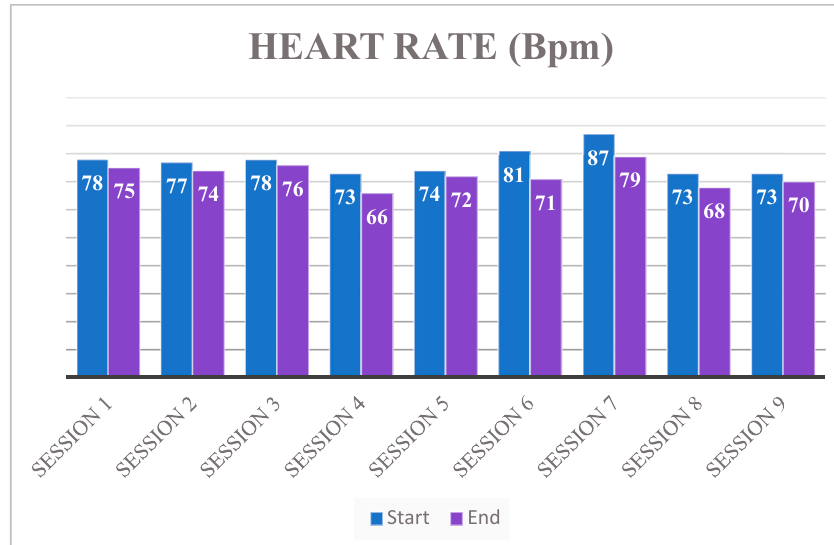
Figure 3. Heart rate trend.